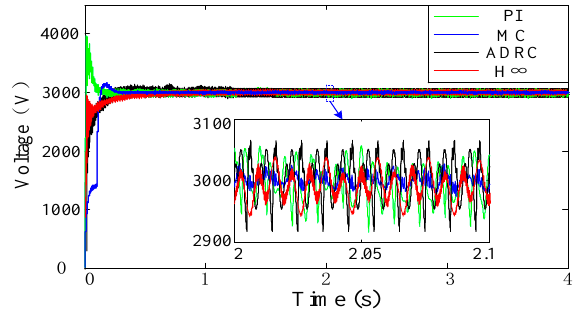
Energies 2018 , 11 , x FOR PEER REVIEW 11 of 24 Figure 8. Waveforms of the DC-link voltage of the converter. Figure 8. Waveforms of the DC-link voltage of the converter.